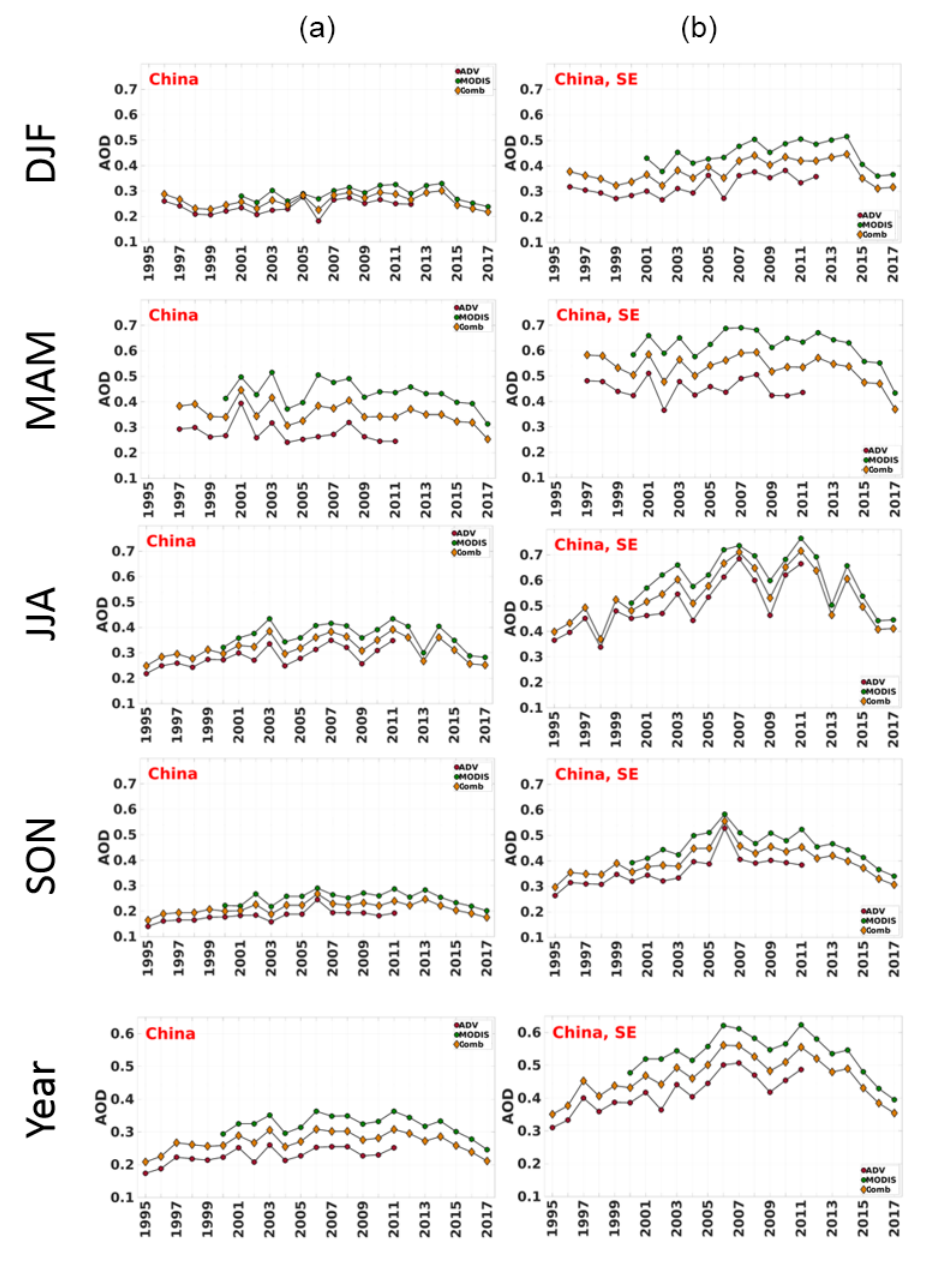
Figure 4. ADV (red circles), MODIS (green circles) and combined from ADV and MODIS (yellow diamonds) seasonal and annual AOD time series for China (a) and SE China (b) for winter (DJF), spring (MAM), summer (JJA), autumn (SON) and the whole year (Year). The method used to combine the ADV and MODIS time series is presented in Sect.